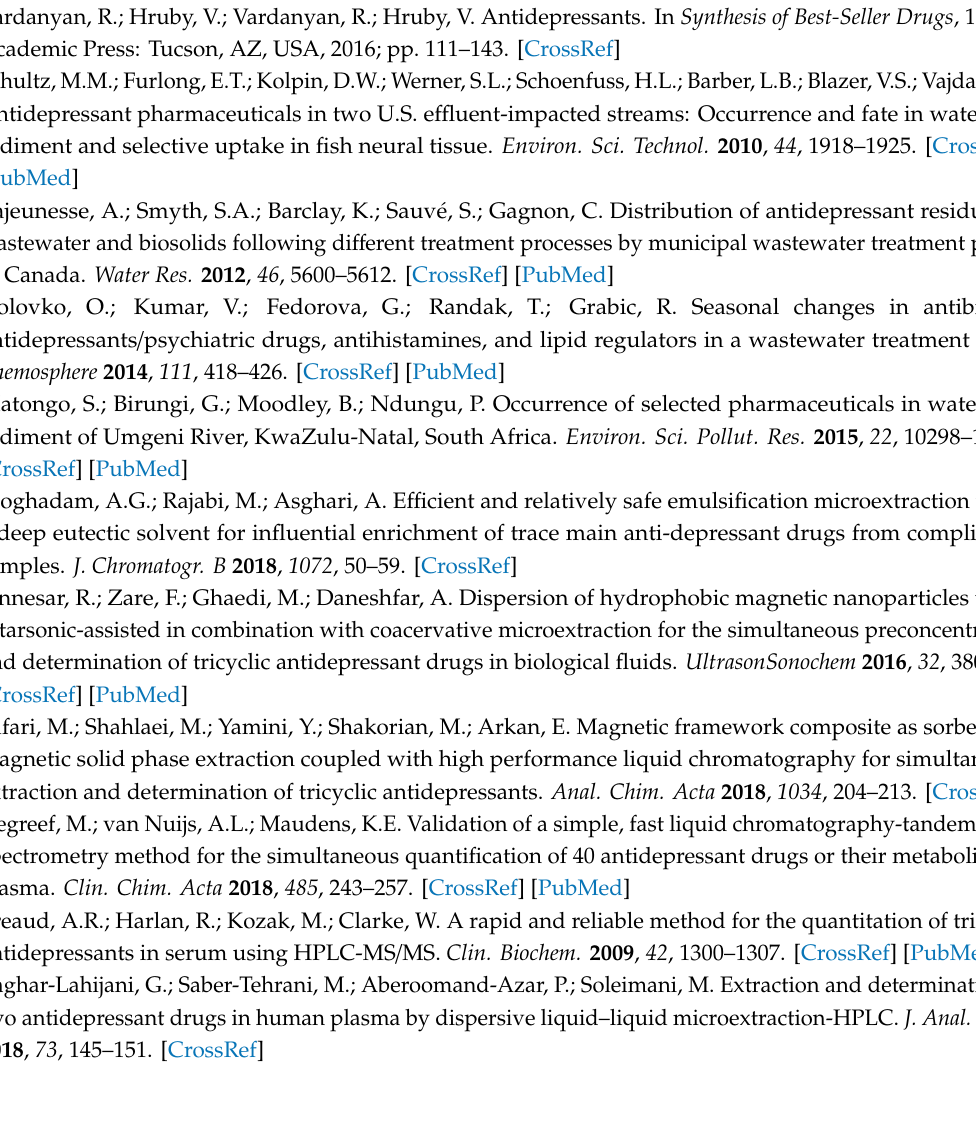
Figure S1: FT-IR spectra of di ff erent components in ( a ) Whatman uncoated material, ( b ) PEG-PPG-PEG polymer, ( c ) MTMS precursor and ( d ) Whatman PEG-PPG-PEG coated media, Figure S2: General procedure applied in FPSE